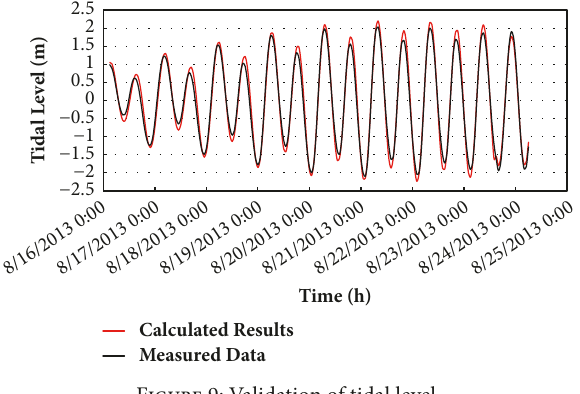
Figure 9: Validation of tidal